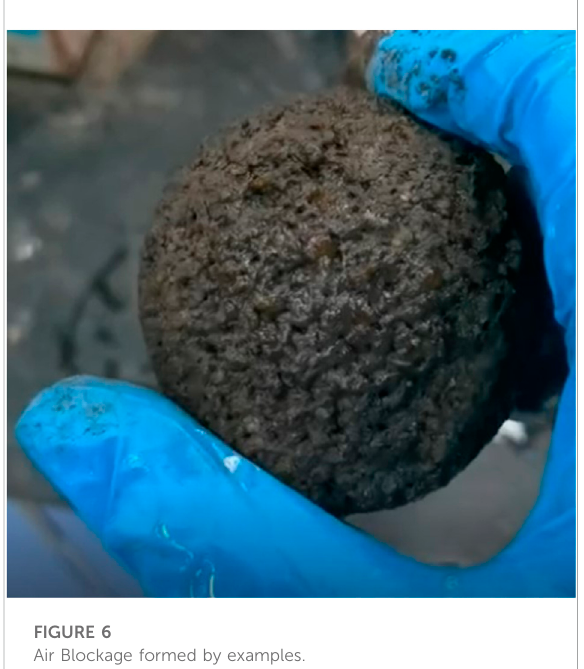
FIGURE 6 Air Blockage formed by